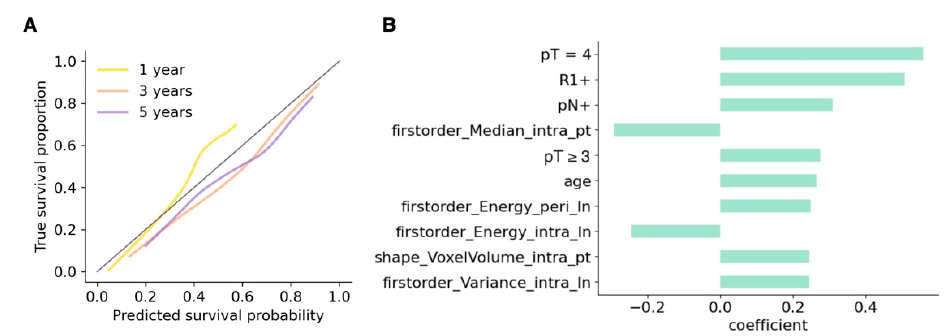
Figure 5. ( A ) Calibration curves for the combined model of predicted survival probability versus true survival proportion for the test dataset at 1, 3 and 5 years. The closer to the diagonal the curves are, the better the calibration. ( B ) The 10 features with the highest coefficient for the combined model correspond to its most important features; R1 = positive surgical margins (positive resection status); intra = imaging features extracted from intratumoral segmentations; peri = imaging features extracted from peritumoral segmentations; pt = primary tumor; ln = lymph node.